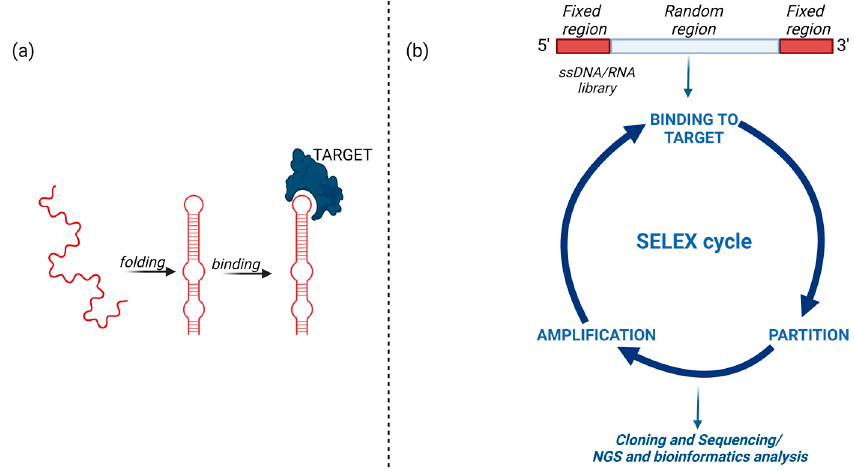
Figure 1. Schematic representation of aptamer binding to its target and key steps of the SELEX method. ( a ) The aptamer adopts a 3D structure to bind to its target; ( b ) The SELEX starts with random libraries of ssDNA or RNA sequences and comprises reiterated rounds of binding to the target, partitioning of the target bound sequences from unbound and amplification of the bound sequences. Finally, the enriched library is analyzed by cloning and sequencing or, in the most recent approaches, high-affinity ligands are identified by next-generation sequencing (NGS) and bioinformatics. Created with BioRender.com (accessed on 2 March 2023).